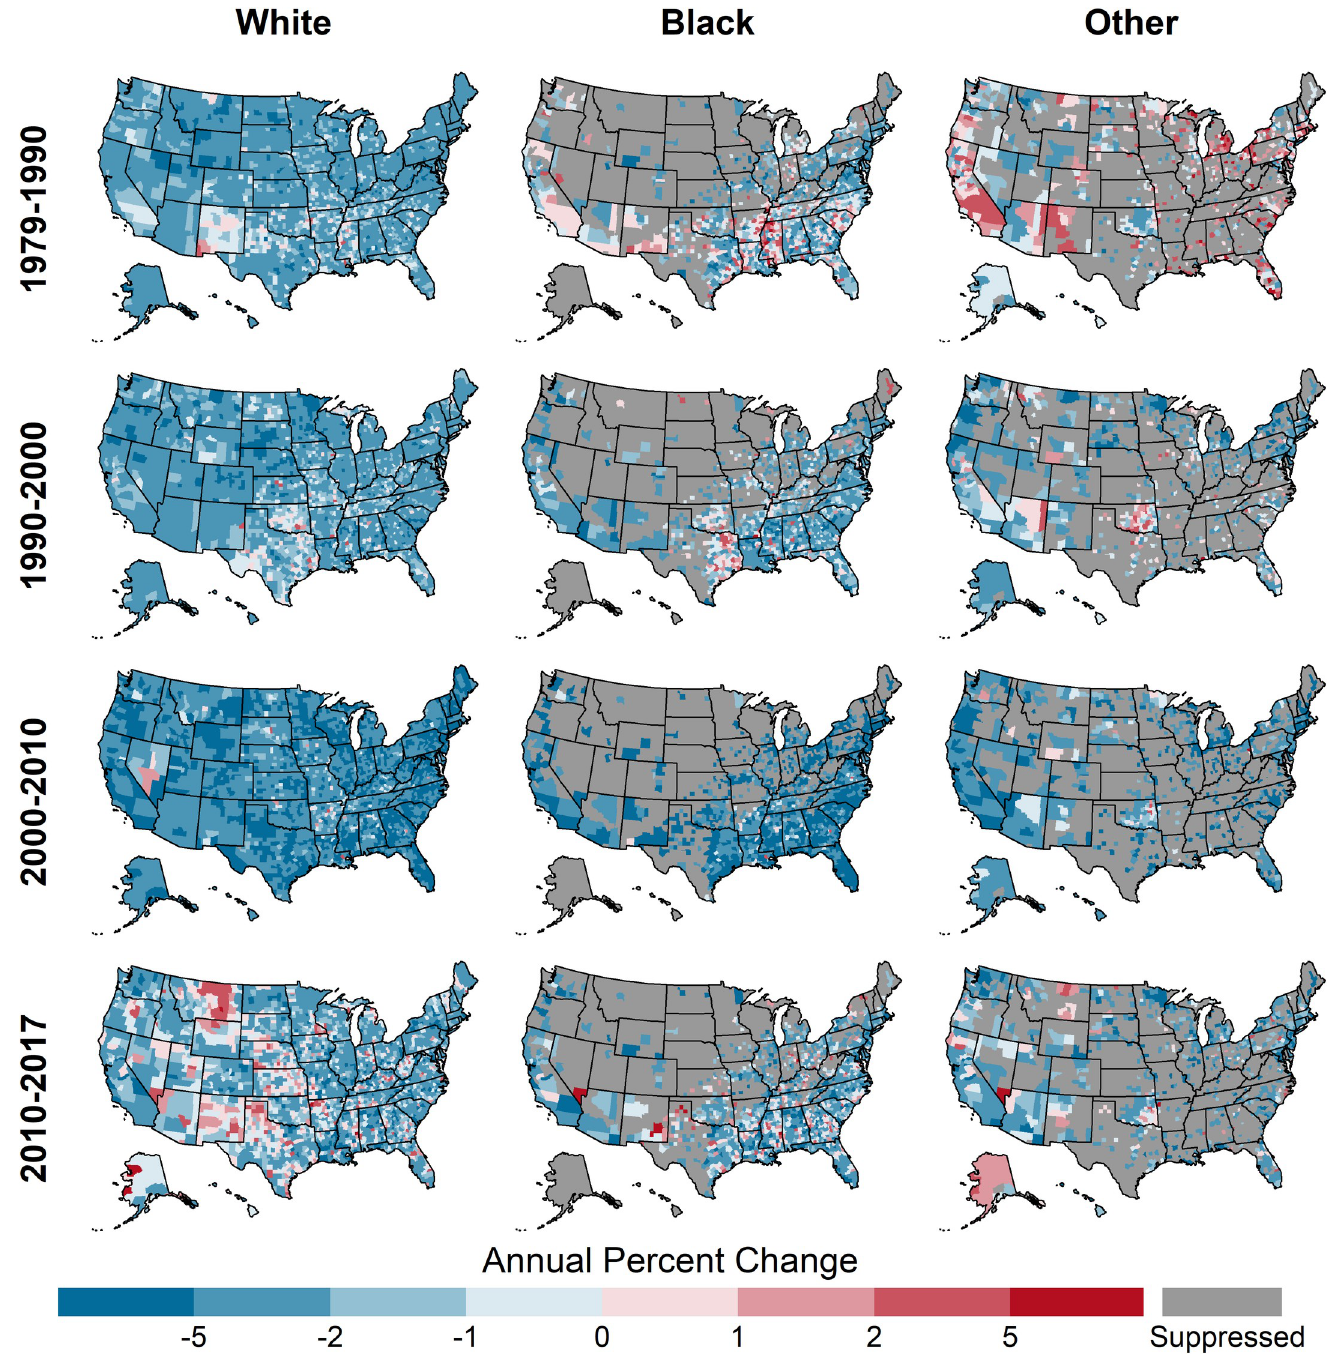
Fig 7. Annual percent change in county-level CHD death rates by year and race, ages 35 and older, United States, 1979–2017.